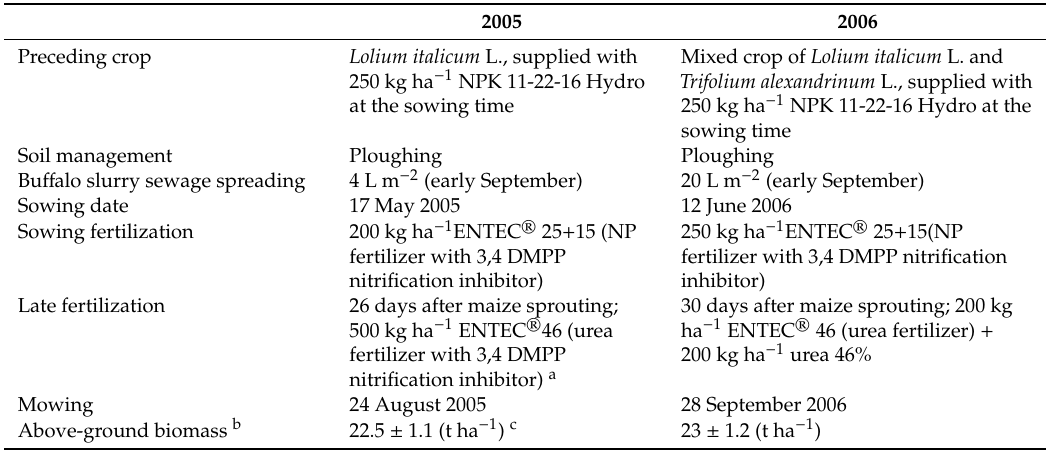
Table 1. The main agronomic practices and output of the Zea mays L. cultivations in 2005 and